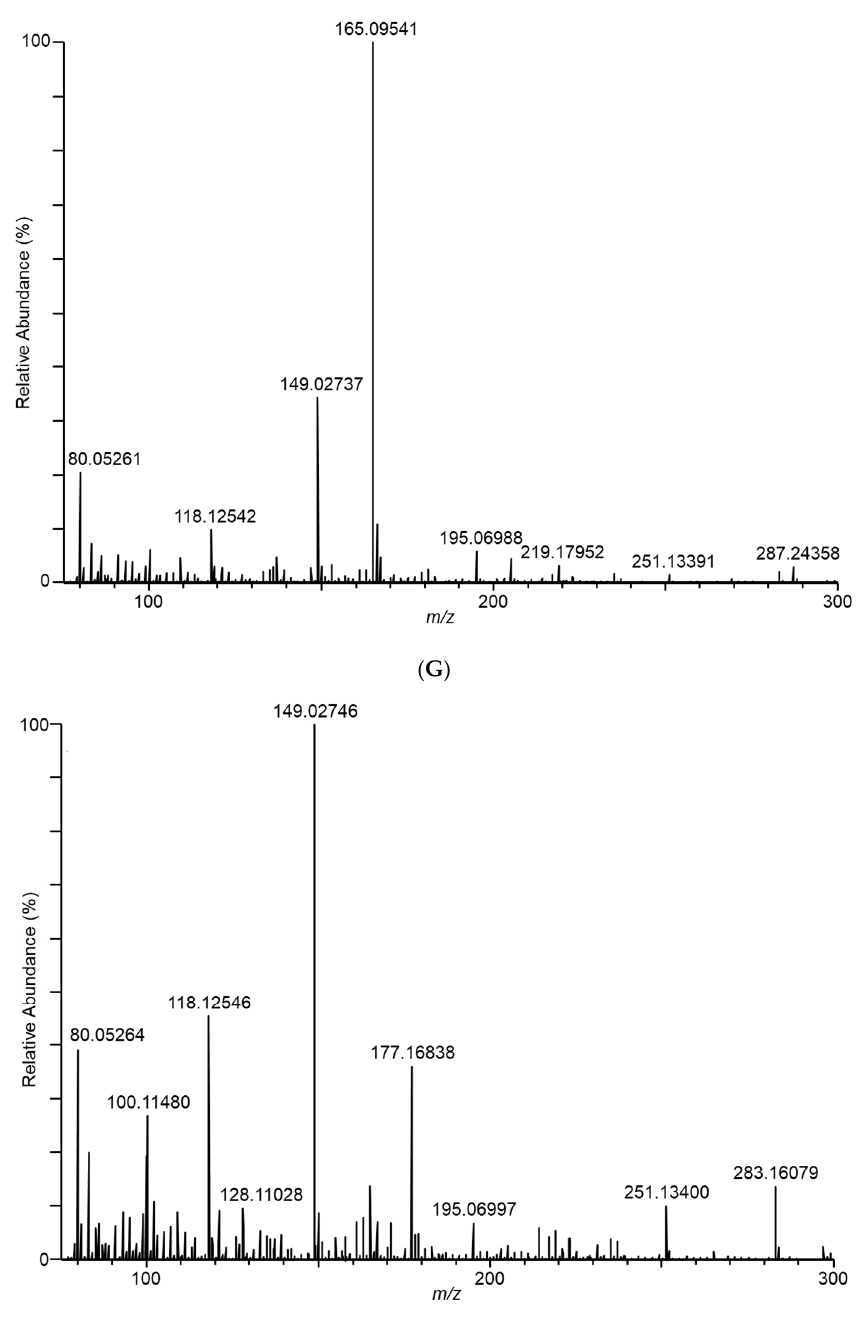
Figure 2. Spectra for ( A ) room air during conduct of the study, ( B ) control cracked maize, ( C ) F. verticillioides on cracked maize, ( D ) F. scirpi on cracked maize, ( E ) F. avenaceum on cracked maize, ( F ) F. graminearum on cracked maize, ( G ) F. virguliforme on cracked maize, and ( H ) A. flavus on cracked maize. Spectra represent averages of the 3 min acquisition period for each sample.